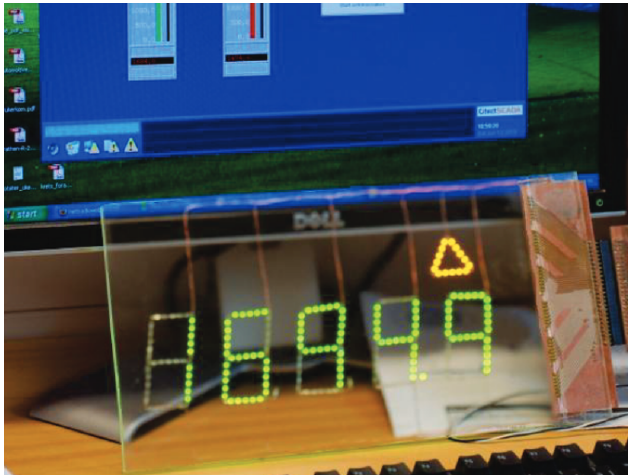
Figure 3. The image shows the transparent display prototype that was developed by Kvalberg [19]. The number indicates the current load that is lifted by an off-shore crane, while the yellow triangle indicates that the lifting load exceeds the permissible